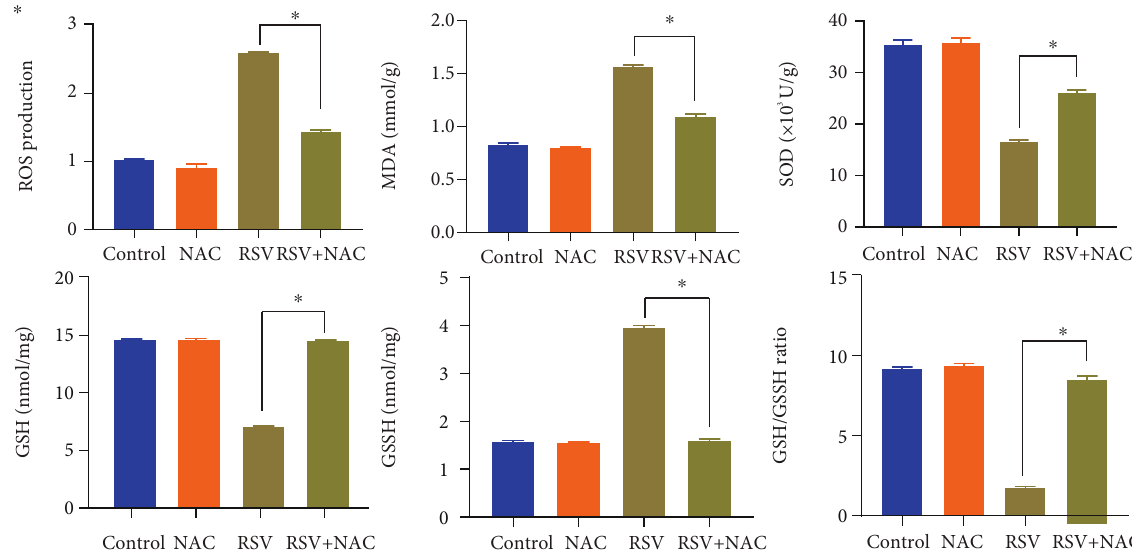
Figure 3: Antioxidant properties of NAC in RSV-infected BEAS-2B cells by detecting the ROS production, MDA level, SOD activity, GSH, GSSH, and GSH/GSSH ratio. ∗ indicates p < 0 : 01 .